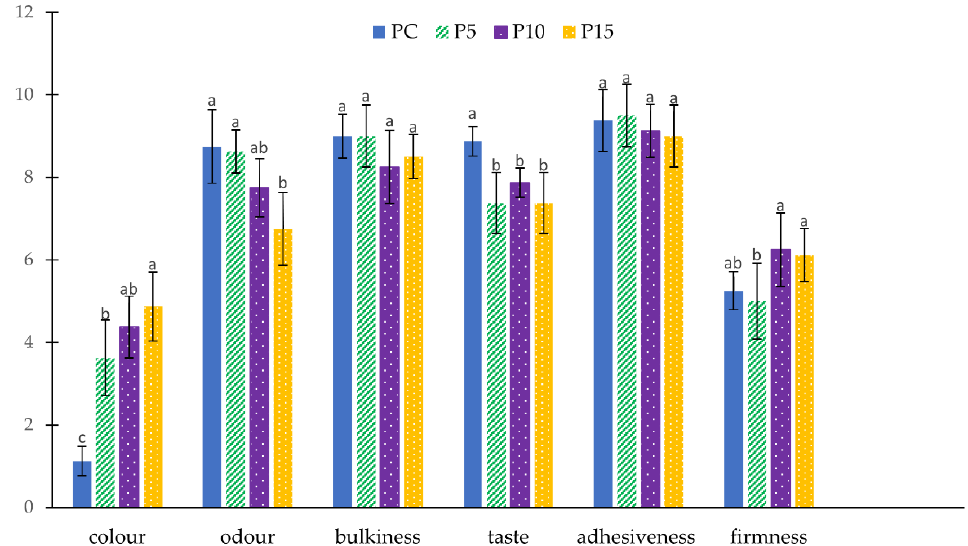
Figure 2. Sensory characteristics of control (PC) and inulin-enriched (P5, P10, P15) fresh pasta. Values are expressed as mean ± standard deviation; different letters for each parameters mean significant statistical differences ( p < 0.05) to one-way ANOVA followed by Tukey’s HSD test.